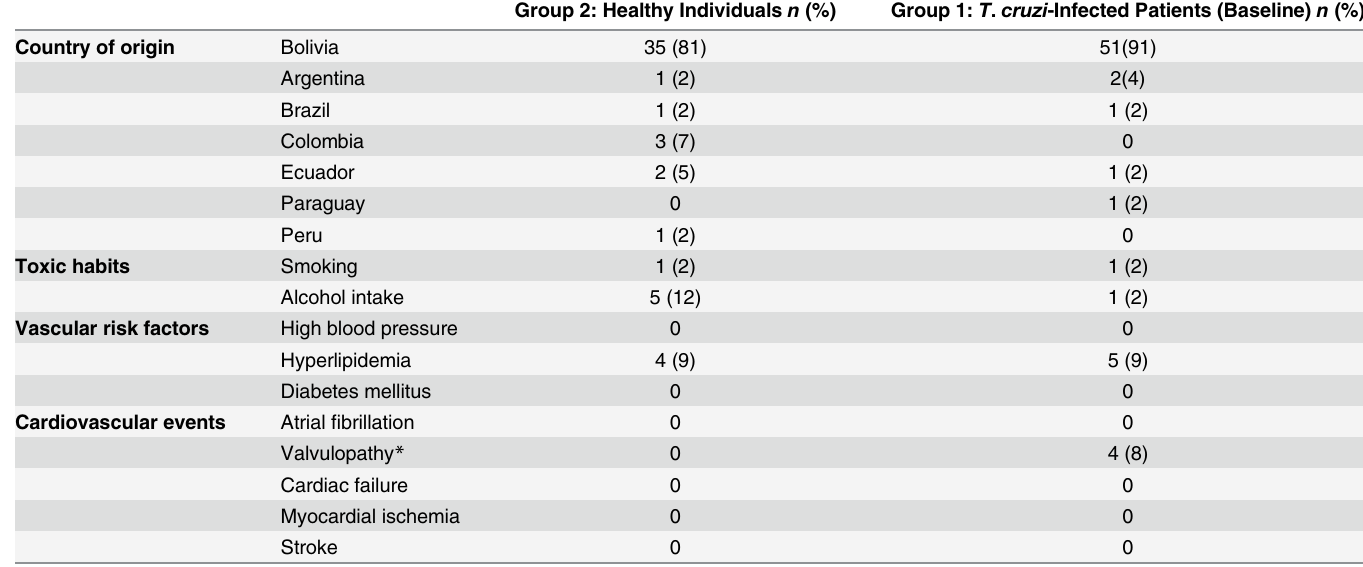
Table 1. Epidemiological data, vascular risk factors, and cardiovascular events in healthy and T . cruzi -infected individuals. Group 2: Healthy Individuals n (%) Country of